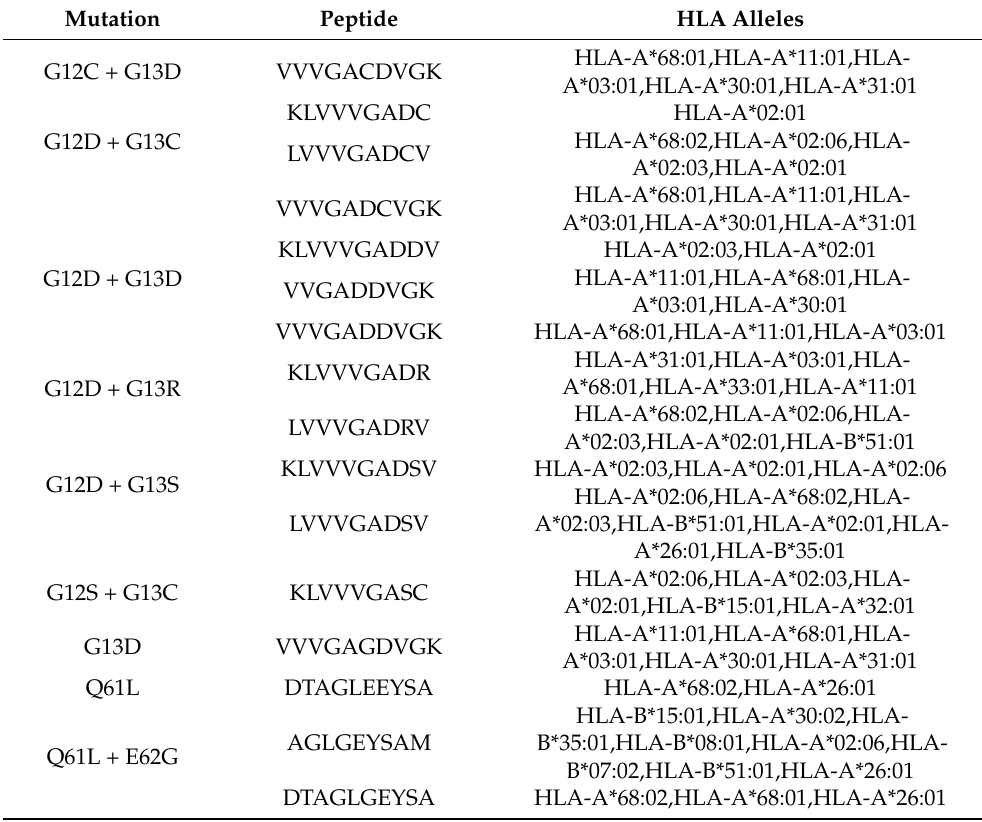
Table 2. Summary of mutations and epitope sequences